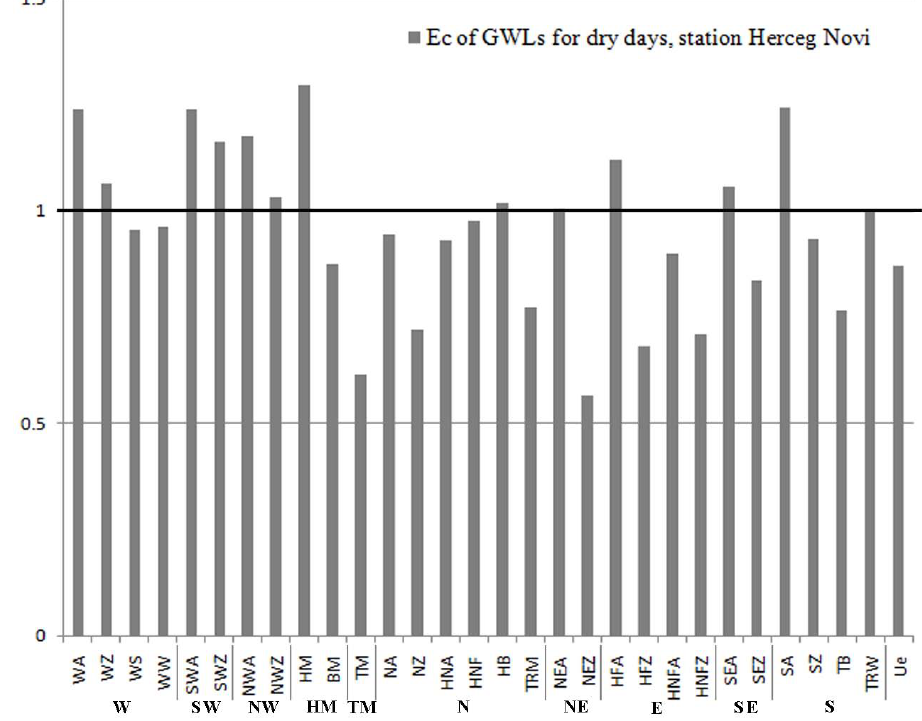
Fig. 8. The efficiency coefficient ( E c ) of GWLs for dry days, station Herceg Novi, period 1951–2007.